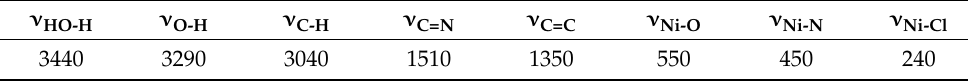
Table 3. IR stretching vibrations (cm − 1 ) of main functional